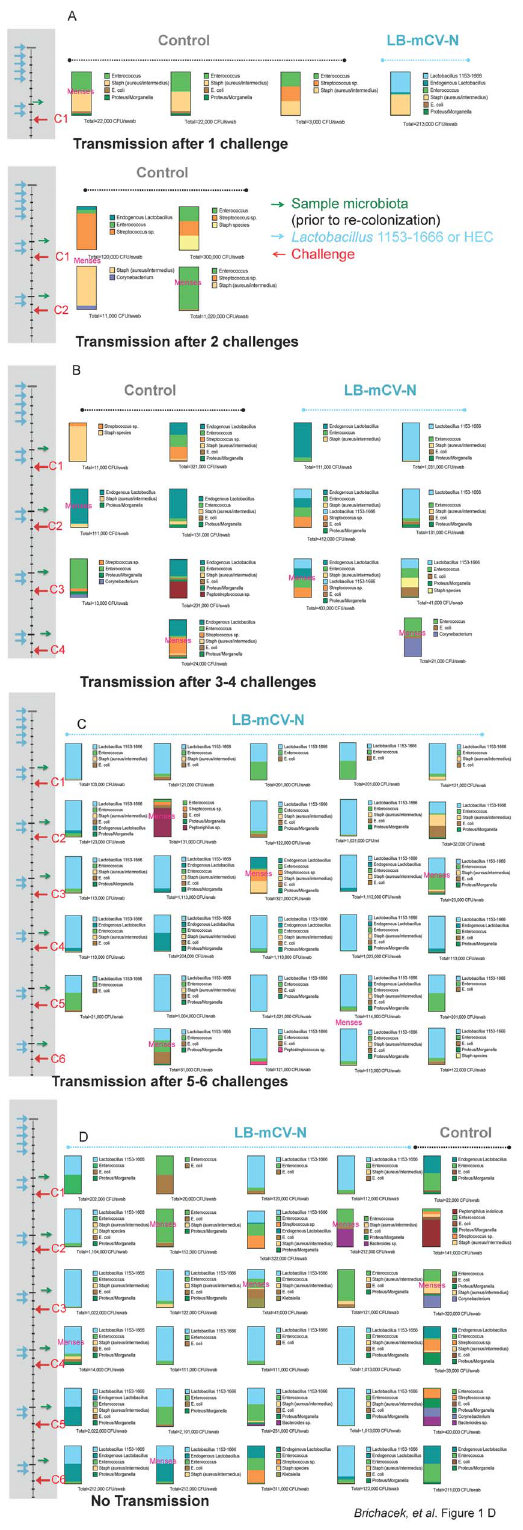
Figure 1. Culturable vaginal microbiota up to the time of transmission for mLB-CV-N colonized and control macaques. Each vertical column represents one macaque. Samples were taken two days prior to each challenge and cultured on standard and selective plating media. Bacteria were identified by Gram stain, API biochemical analysis and 16S rRNA sequence. Stacked bar graphs are used to